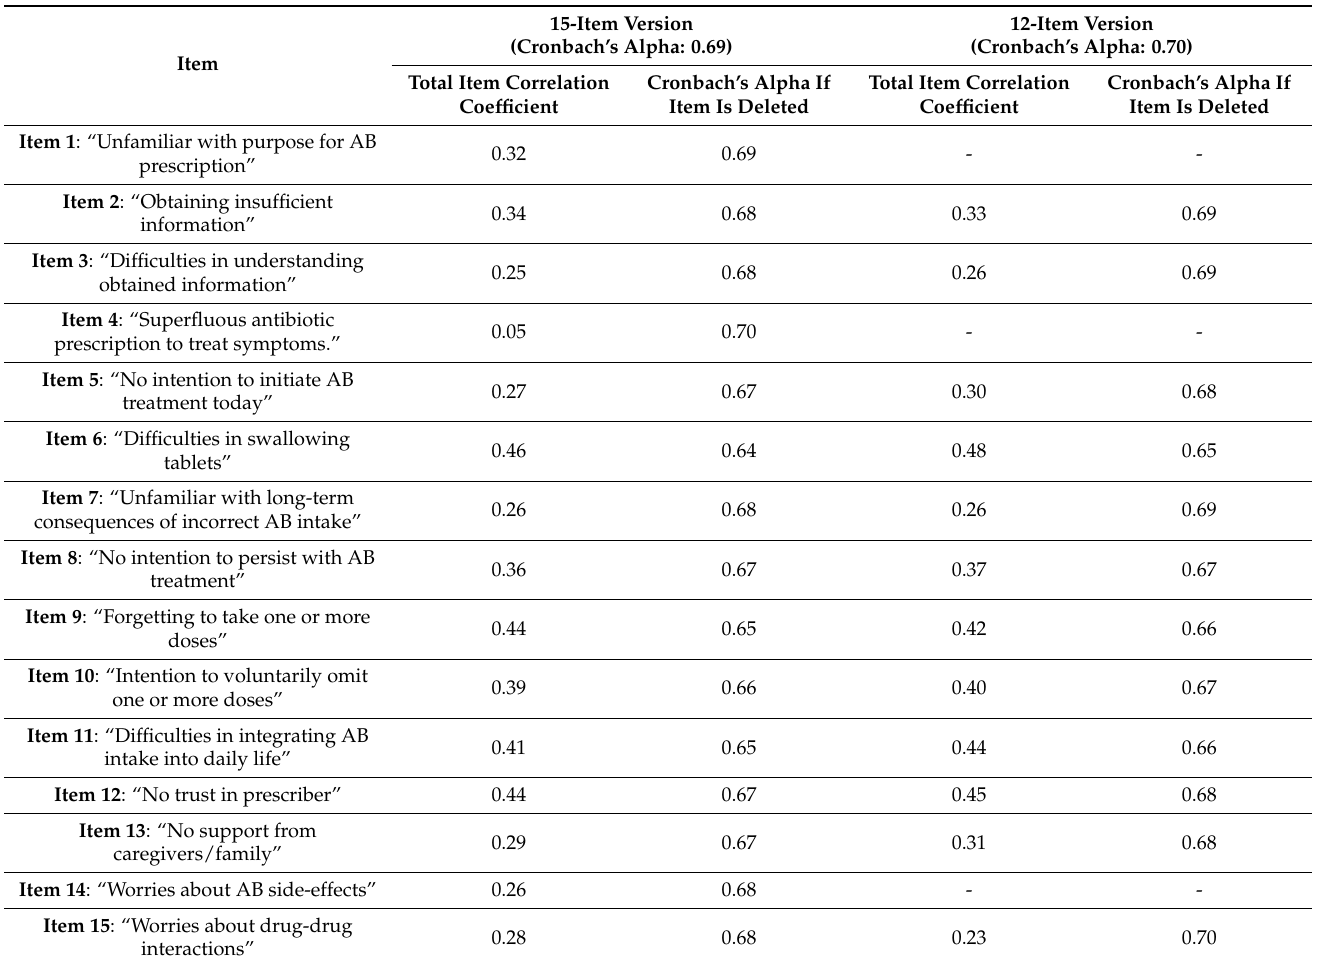
Table 4. Reliability assessment of the questionnaire (BIOTICA) using total item correlation coefficients and changes in Cronbach’s alpha if a particular item is